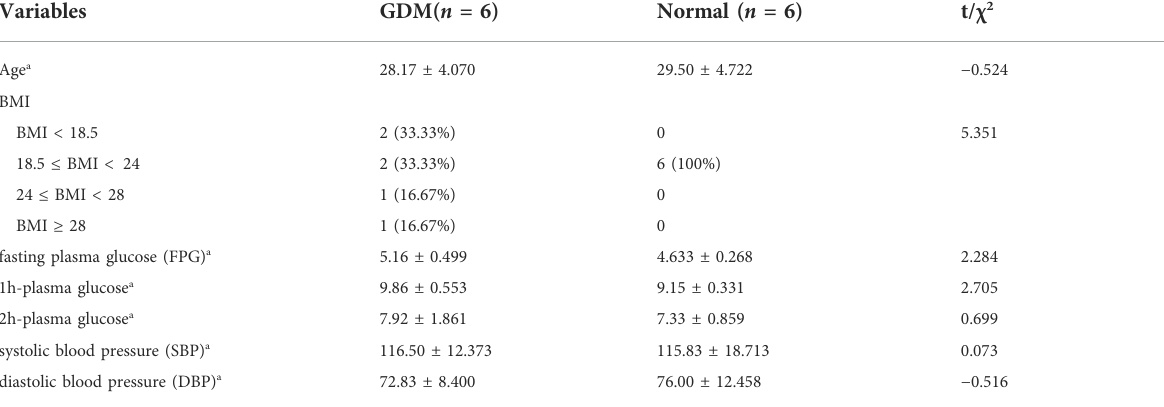
TABLE 1 Characteristics of the subjects enrolled for miRNA expression analysis in the study.